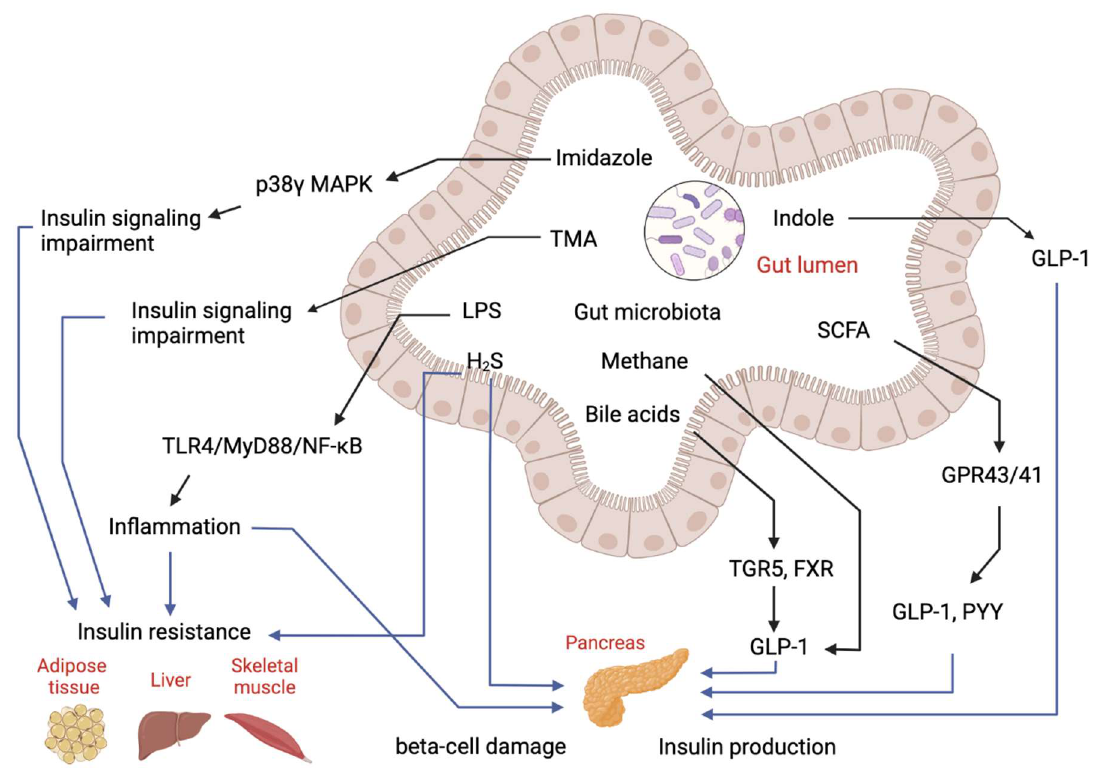
Figure 2. Regulatory effects of gut-microbial metabolites on insulin sensitivity and insulin production. Imidazole, TMA, LPS and hydrogen sulfide (H 2 S) can cause either insulin resistance or beta-cell damage to impair glucose homeostasis. Bile acids, SCFA and indole can stimulate GLP-1 production to manipulate insulin production and secretion to regulate glucose level.